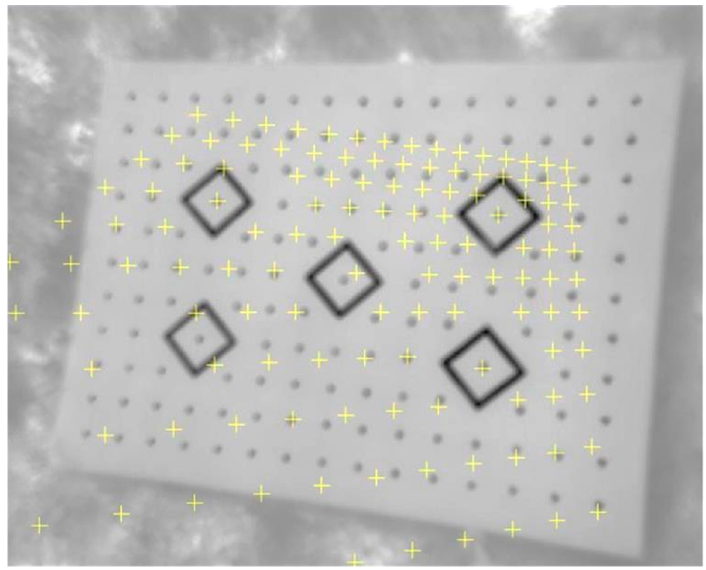
Figure 7. Raw, uncorrected test image with misidentified